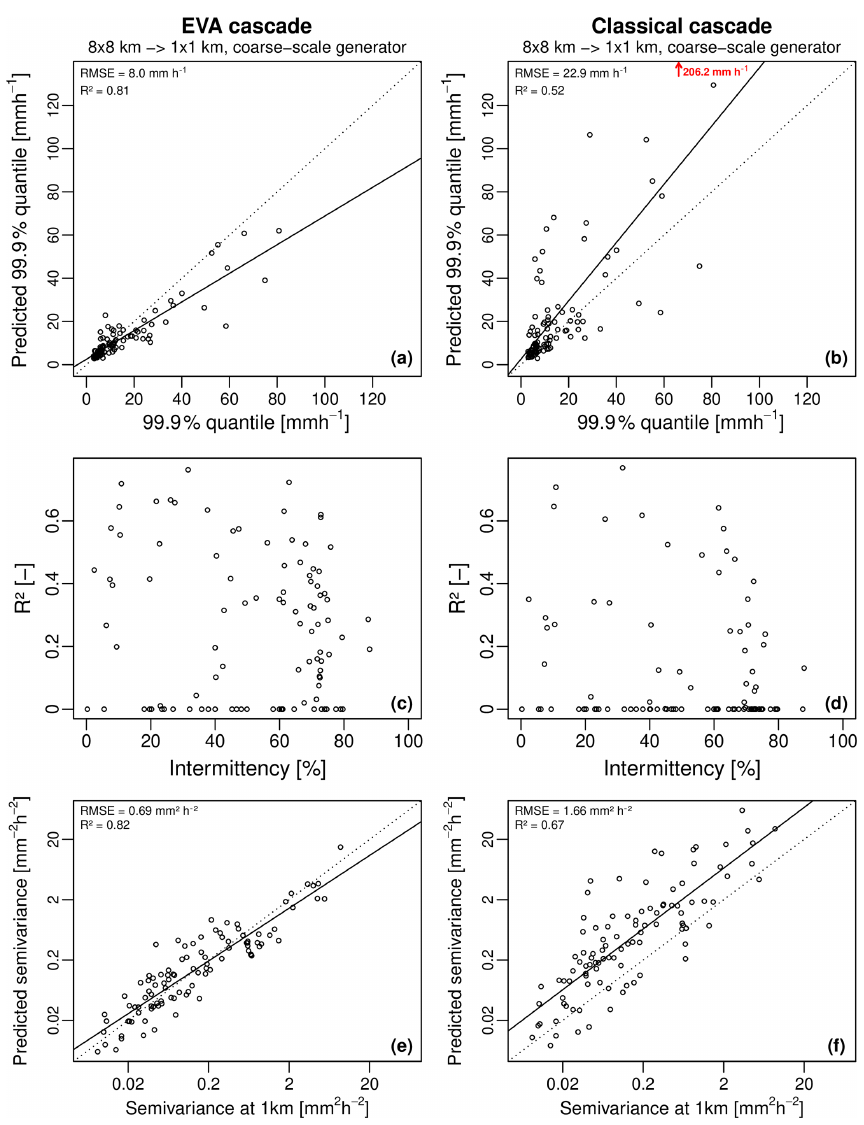
Figure 15. Overall performance of the random cascade models for 100 high-resolution radar rainfall fields, coarse-scale sample generator estimate and downscaling factor of 64 (i.e., input resolution of 8km × 8km and target resolution of 1km × 1km). Panels (a) and (b) show the predicted versus observed 99.9% quantile of rainfall intensity, (c) and (d) the coefficient of determination R 2 between downscaled and observed rainfall rates as a function of intermittency (i.e., the fraction of zero rainfall values in the domain), and (e) and (f) show the predicted versus observed semivariance values for a 1km spatial displacement. The EVA cascade is shown on the left and the classical cascade on the